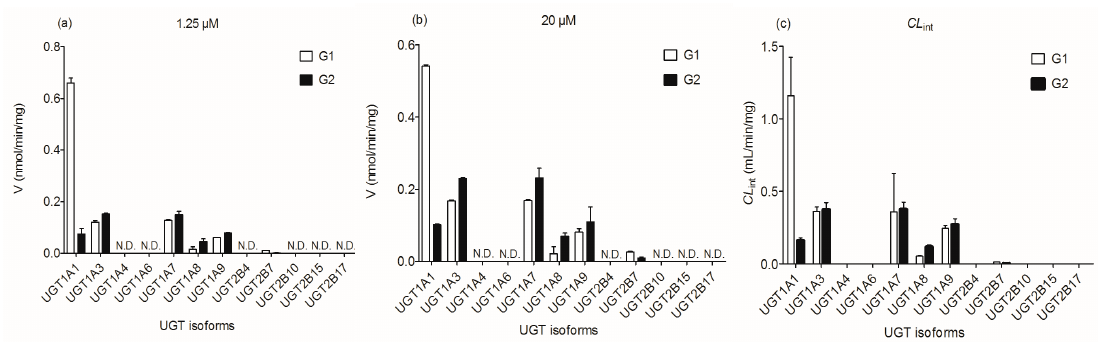
Figure 3. Comparisons of glucuronidation rates ( a ) 1.25 μ M; ( b ) 20 μ M and the intrinsic values ( CL int ) ( c ) of wushanicaritin by twelve expressed UGT enzymes. All experiments were performed in triplicate. Data are expressed as the mean ± SD. N.D.: not detected. G1: wushanicaritin-3- O -glucuronide; G2: wushanicaritin-7- O -glucuronide.